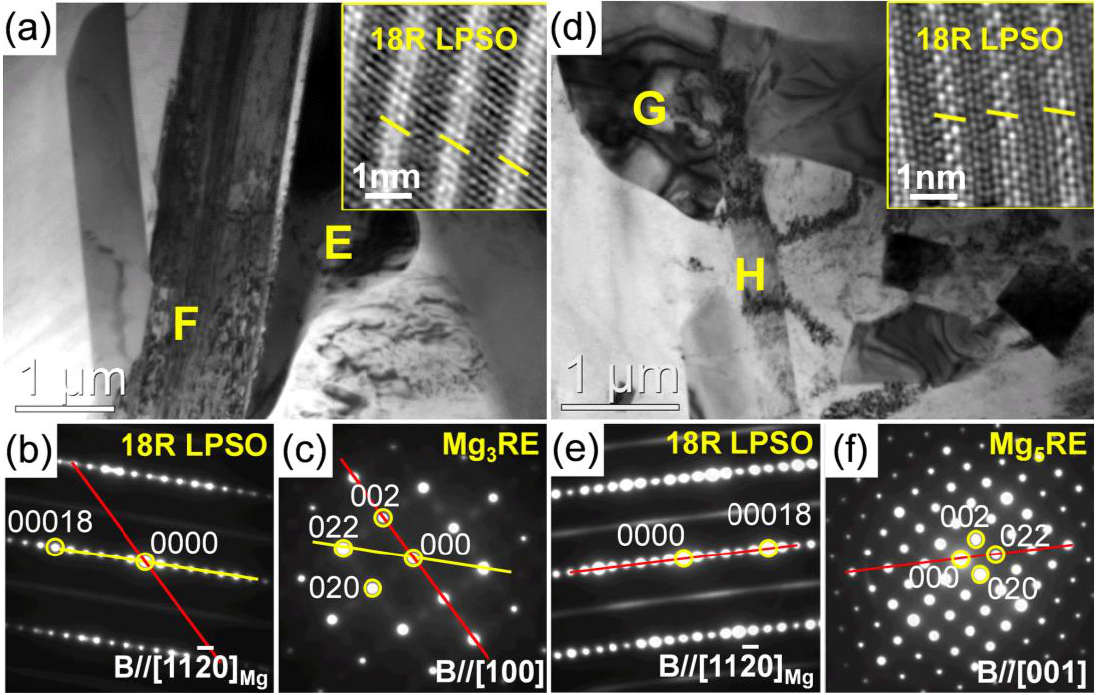
Figure 9. BF-TEM images along with the corresponding SAED patterns of the secondary phases in as-cast alloy: ( a – c ) 0.5Zn-1.0Al and ( d – f ) 0Zn-1.0Al. Table 1. Summary of the point results of the studied